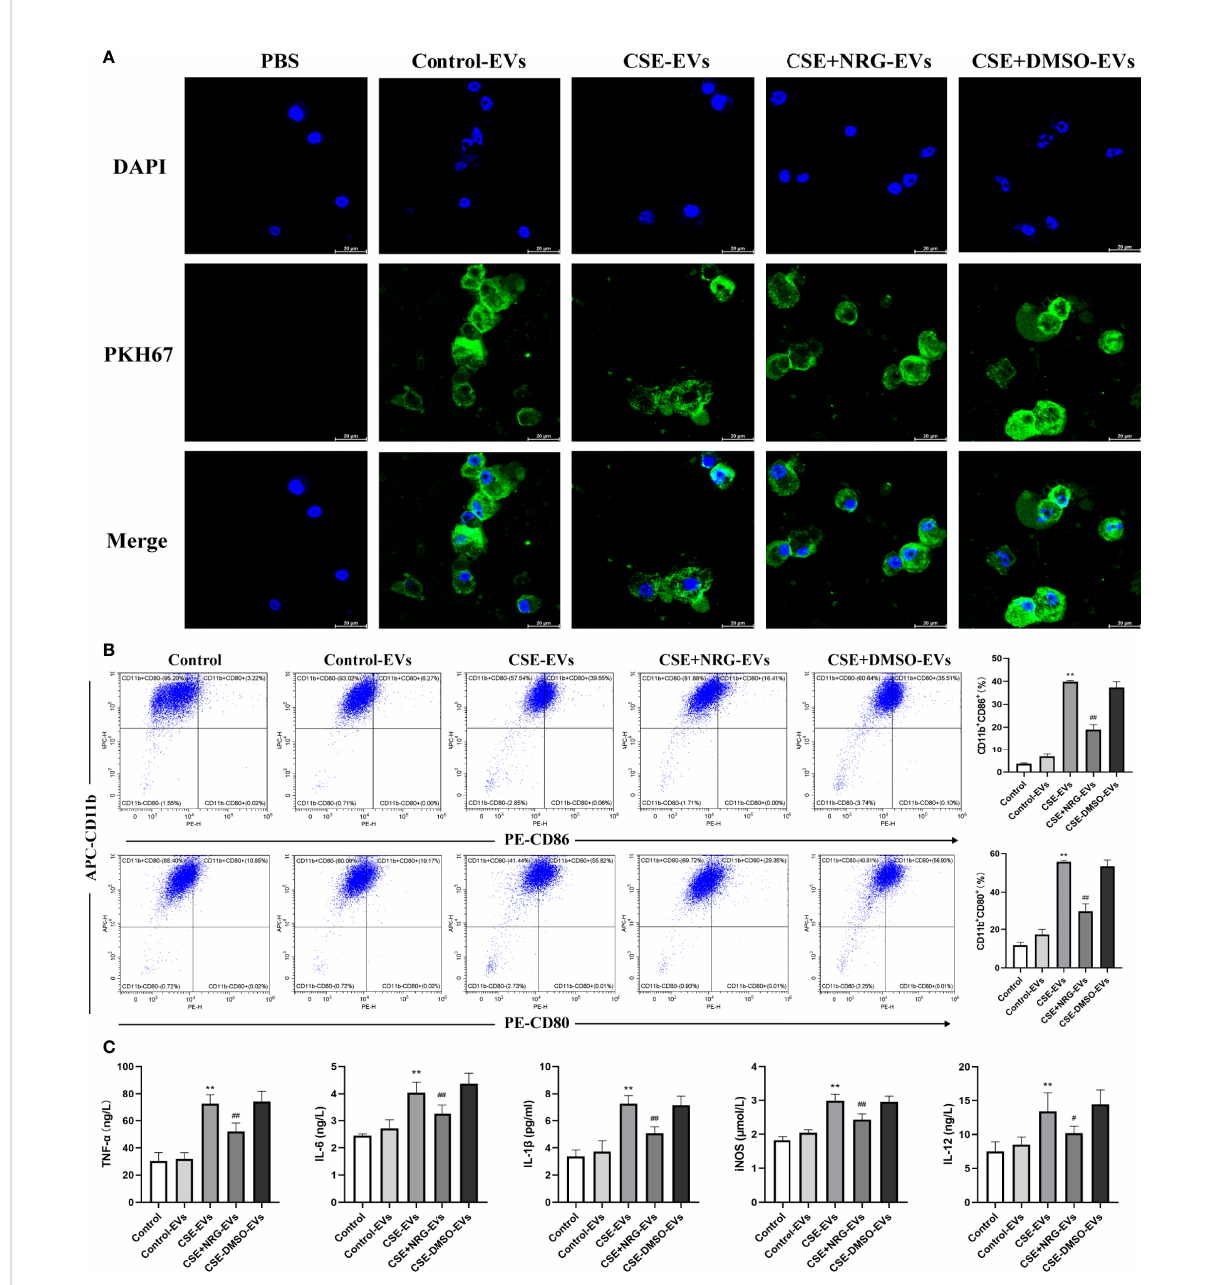
FIGURE 5 CSE+NRG-EVs inhibited M1 macrophage polarization of THP-1 macrophages induced by CSE-EVs. (A) Uptake of BEAS-2B-derived EVs by THP-1 macrophages detected by confocal microscopy. Scale bar = 20 m m. (B) Flow cytometry analysis of the percentages of CD86 + and CD80 + THP-1 macrophages treated with different groups of EVs (n = 3). (C) ELISA was performed to measure the secretion levels of TNF- a , IL-6, IL-1 b , iNOS, and IL- 12 of THP-1 macrophages (n = 6). ** p <0.01 vs . Control-EVs group. # p <0.05, ## p <0.01 vs . CSE-EVs